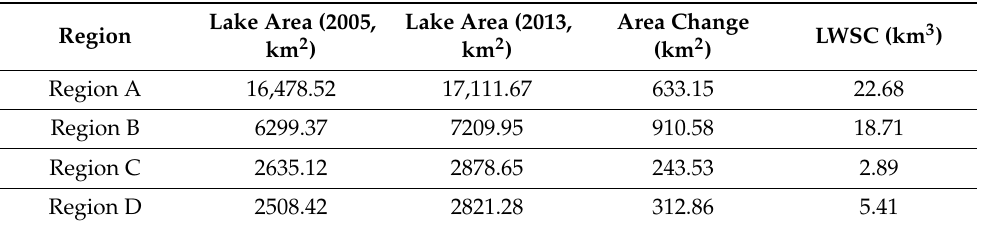
Table 1. The change of lake area and lake water storage from 2005 to 2013 based on Landsat images and